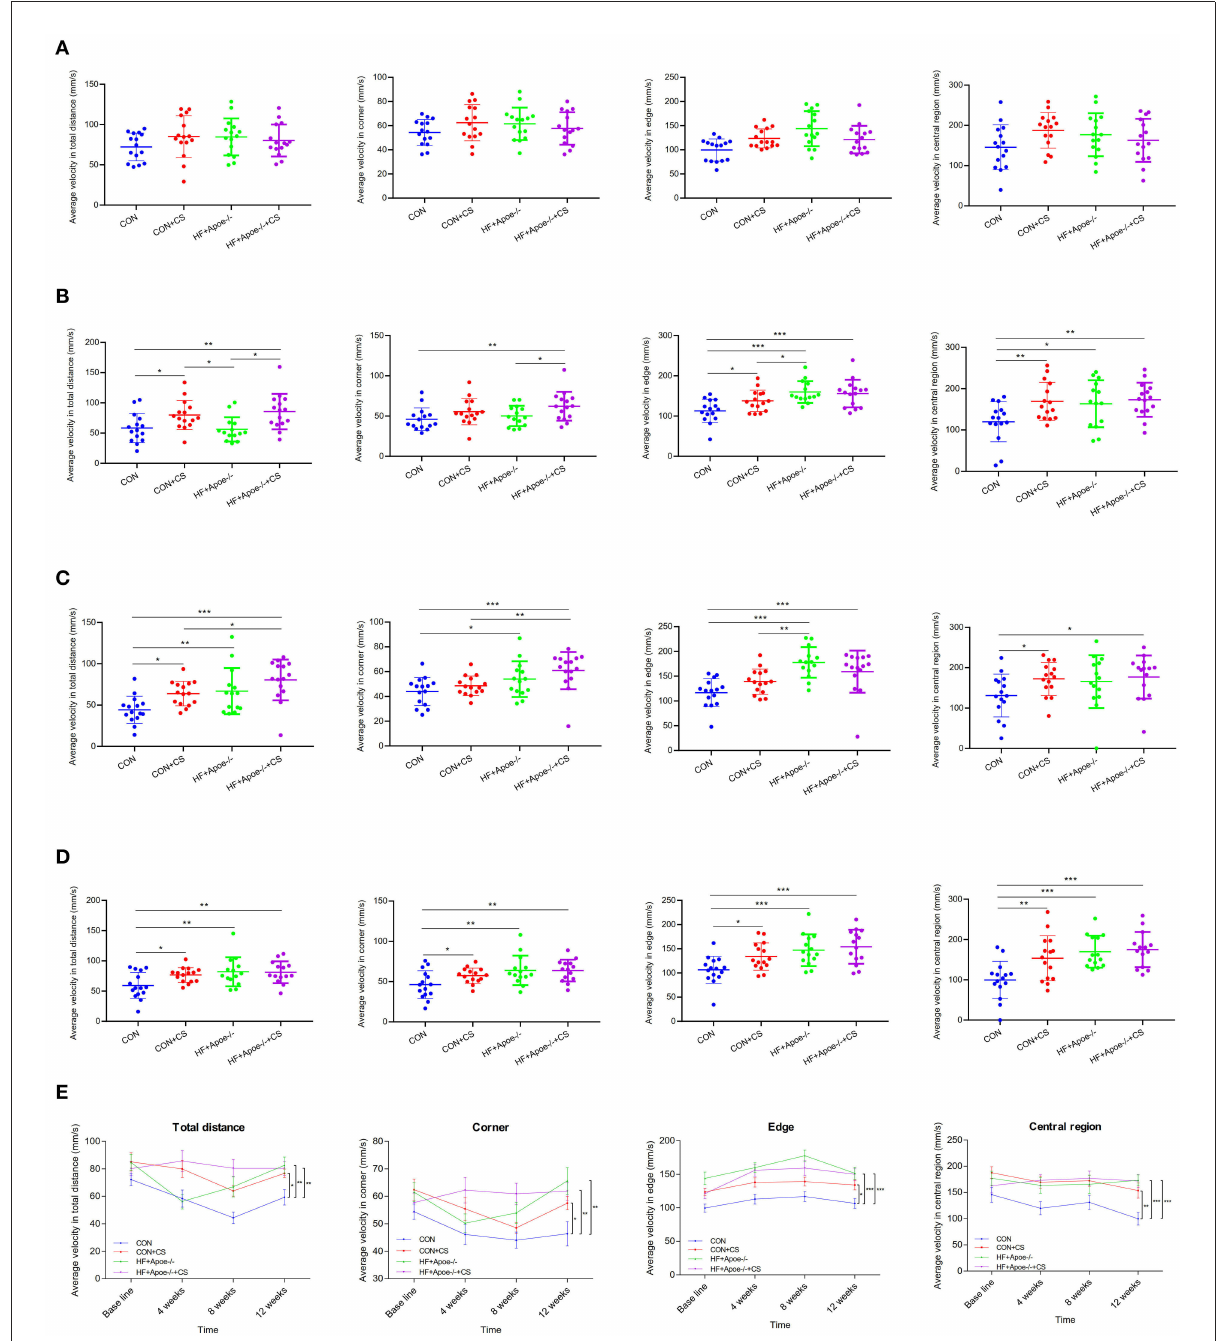
FIGURE2 Verification of the successful construction of a chronic stress model via the open field test. (A) Baseline. (B) Four weeks. (C) Eight weeks. (D) Twelve weeks. (E) Trend of excitation over time is shown in the line chart. * P < 0.05; ** P < 0.01; *** P < 0.001.